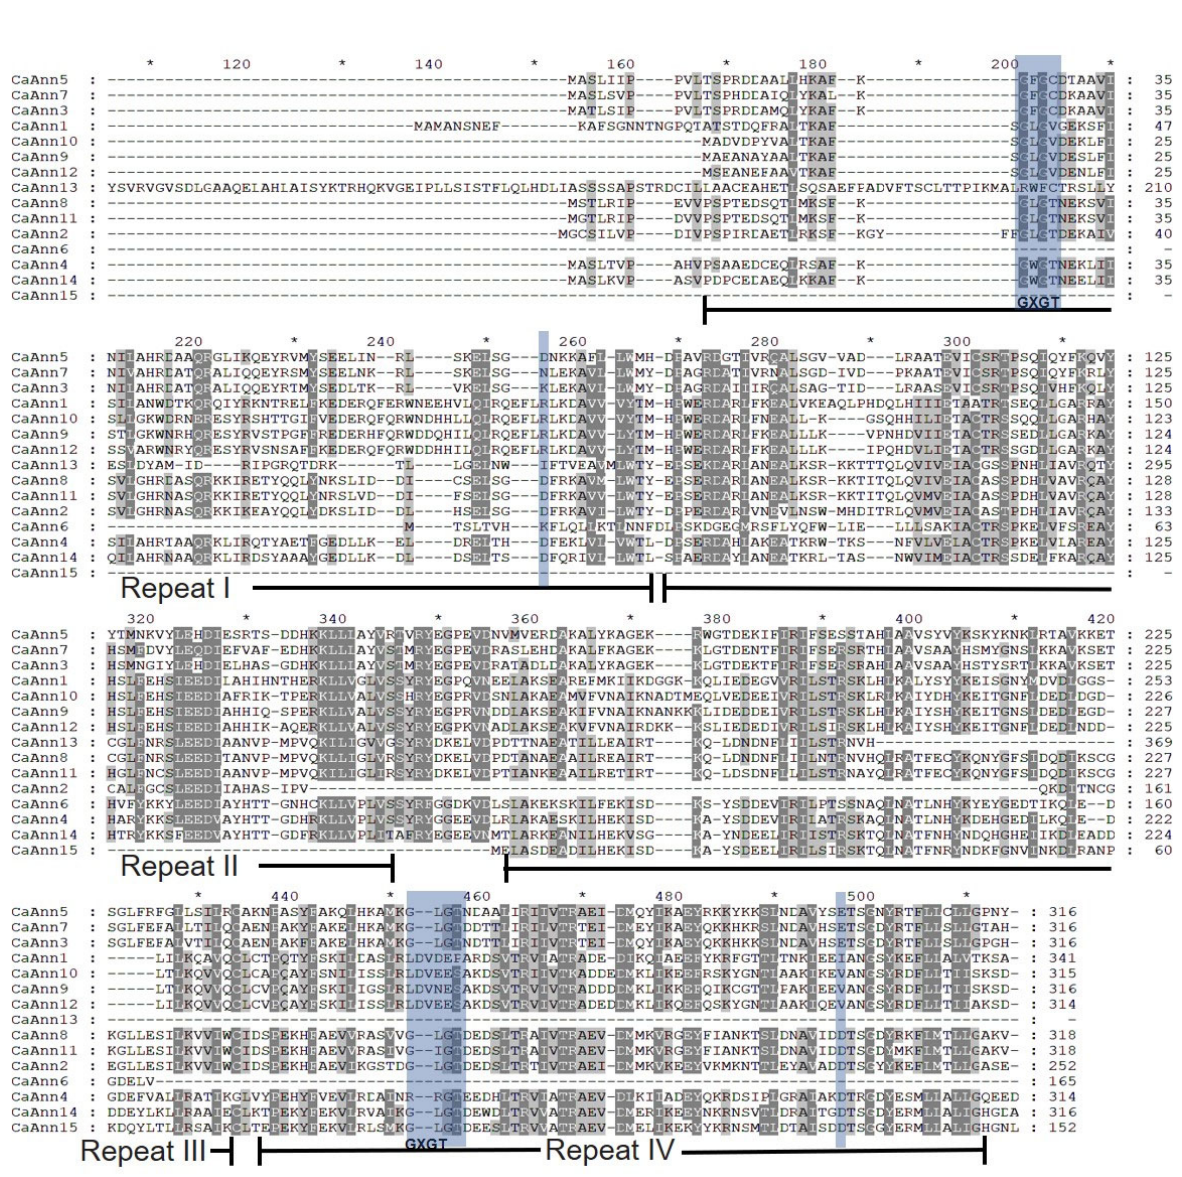
Figure 1. Amino acid sequence alignment of pepper CaAnn proteins. The alignment was performed using Clustal X. The putative annexin repeats (I to IV) are shown below the sequences. The conserved protein sequence (GxGT-[38 residues]-D/E) are shown in blue.